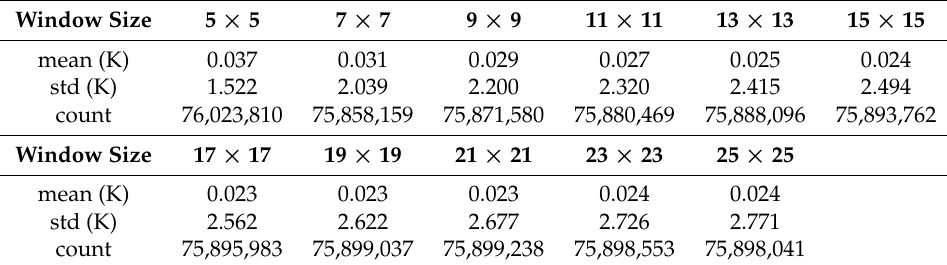
Table 4. Mean and standard deviation of the contextual estimate differences from central brightness temperature (AHI Band 7) for all available pixels in the 36-day set of full disk images at 0500 UTC. A total of 76,023,810 pixels were examined over the 36 images used in the